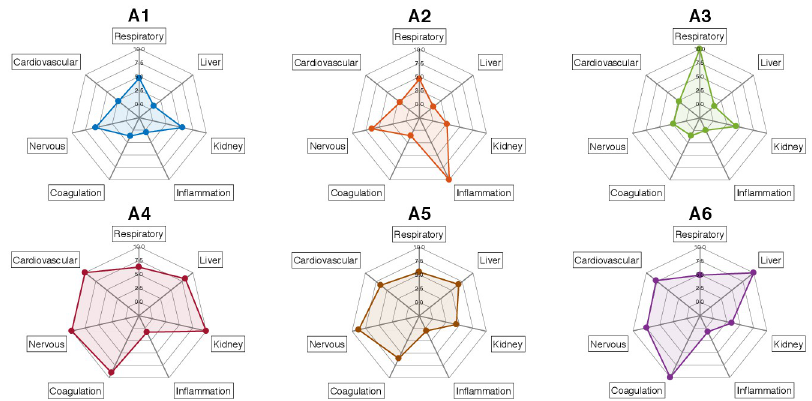
Fig 4. Spider-plot of primary functions affected in each sepsis state (represented by corresponding colors). There are seven different dimensions of primary function for each sepsis sate. The measured dimensions are nervous system, inflammation and infection, liver function, kidney function, coagulation, respiratory function, and cardiovascular function , respectively. The scale of each dimension ranges from 0 to 10, with higher values indicating higher affect on the primary